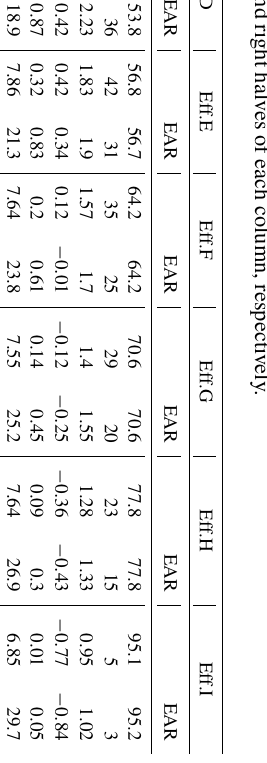
line parameterization. Major controls on the spatial distribu- tion of irrigation reuse included the (a) administrative basin extent and the balance of incidental returns in reservoirs act- ing as irrigation source, (b) upstream catchment area, and (c) presence of the ESPA. Reservoirs received incidental re- turns in runoff from upstream croplands. The fraction of in- cidental returns in surface irrigation for entire administra- tive basins reflect the fraction of irrigation returns stored within the collection of source reservoirs. Therefore, the reuse changed abruptly at administrative basin boundaries (Fig. 1). Source reservoirs were not defined in Wyoming